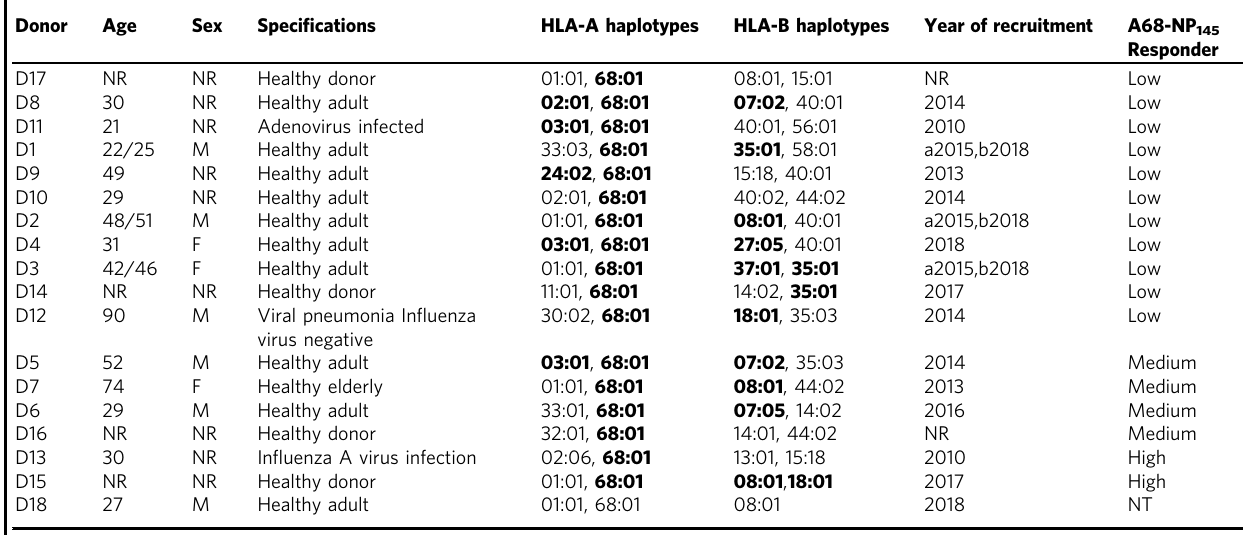
HLA bold indicates HLA used for TAME NR not reported, NT not